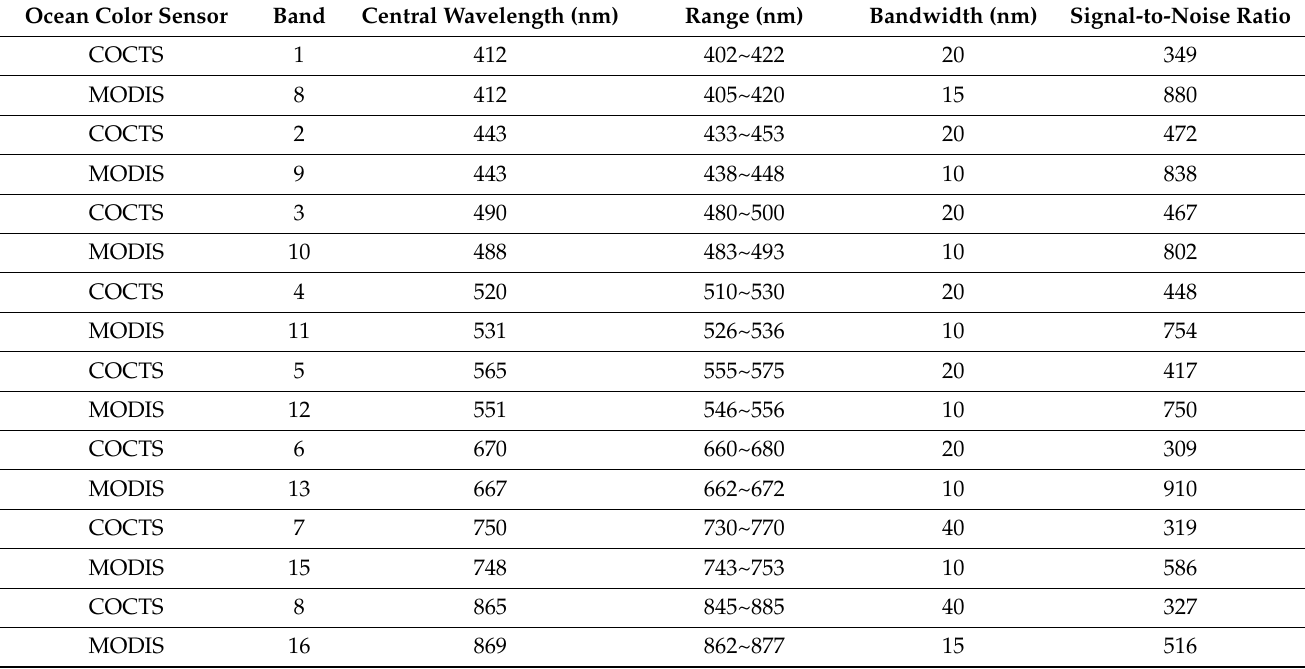
Table 1. Comparison of the technical specifications between the COCTS and MODIS